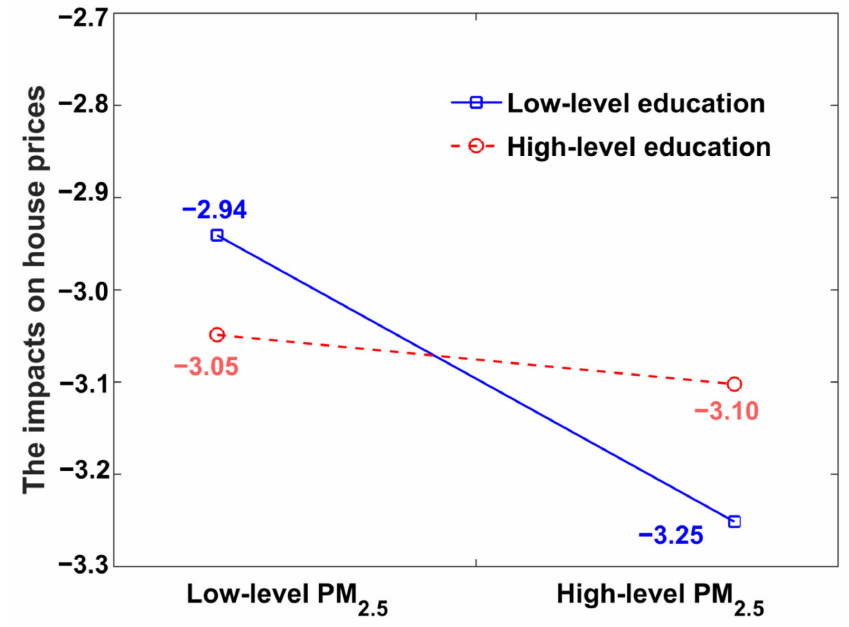
Figure 6. Moderating effect of education on the impact of PM 2.5 on house prices.